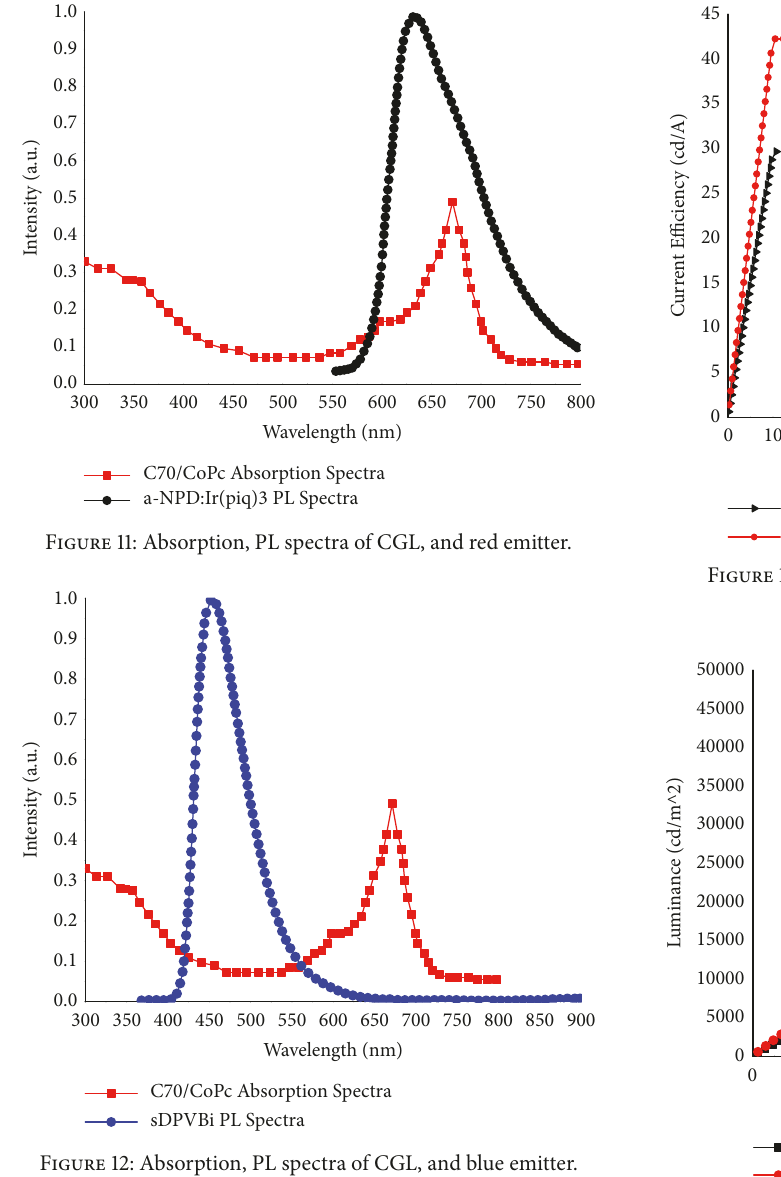
Figure 12: Absorption, PL spectra of CGL, and blue emitter.